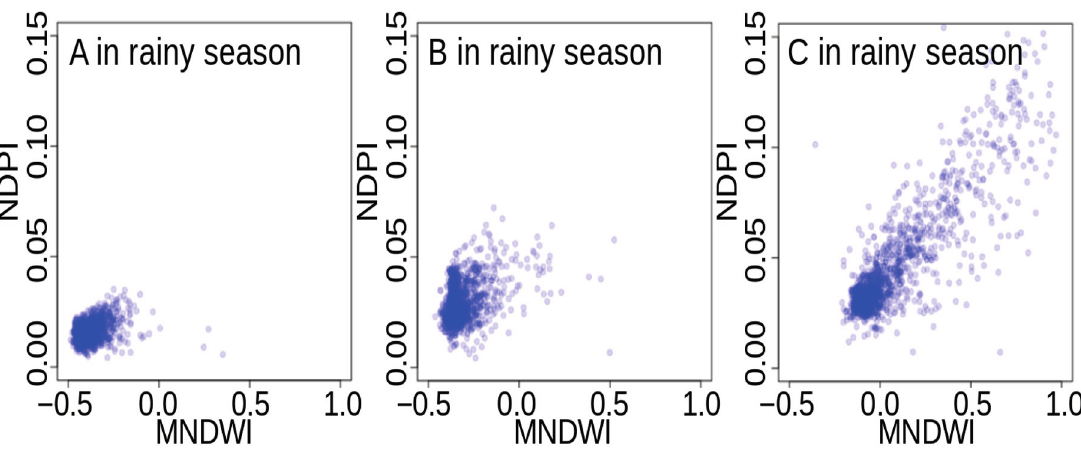
Figure 5. Scatterplots of the correlation between MNDWI and NDPI during the rainy season. ( A ), ( B ), and ( C ) are the test sites defined in Figure 2.